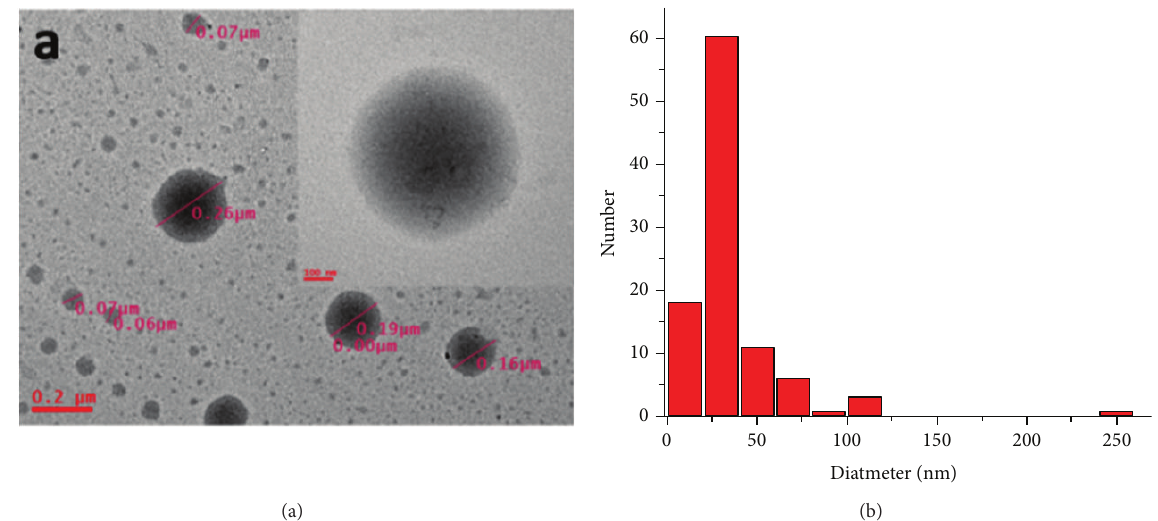
Figure 7: (a) TEM micrograph image of nanovesicles stabilized by PEG-2000; (b) size distribution histogram obtained for stabilized nanovesicles.